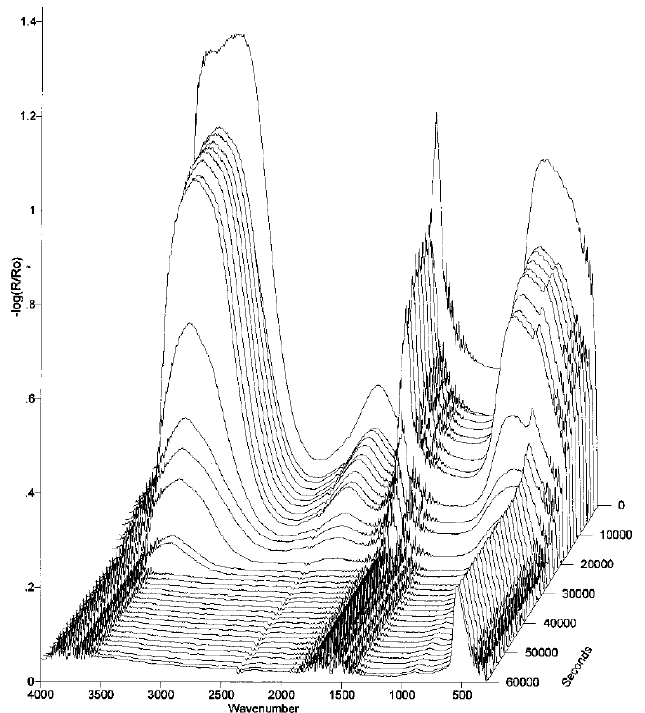
Figure 5. A series of IRRAS spectra acquired during the first drying phase of a zinc surface. of the water bands (~1645 and 3000–3600 cm − 1 ) shows the removal of physisorbed water at the surface. Reproduced from reference [15] by permission of The Electrochemical Society. Copyright